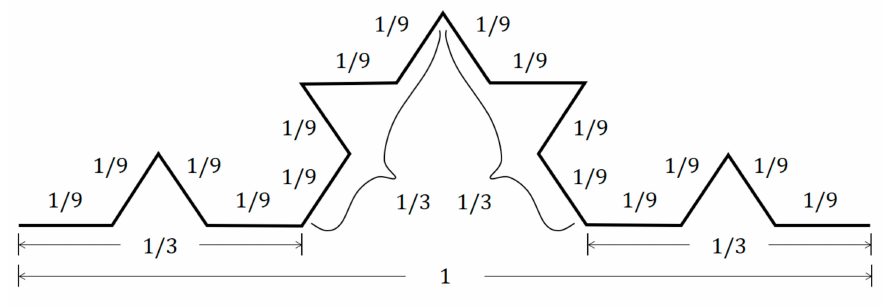
Figure 1. Koch curve, where the length of the shortest line segment is 1 / 9